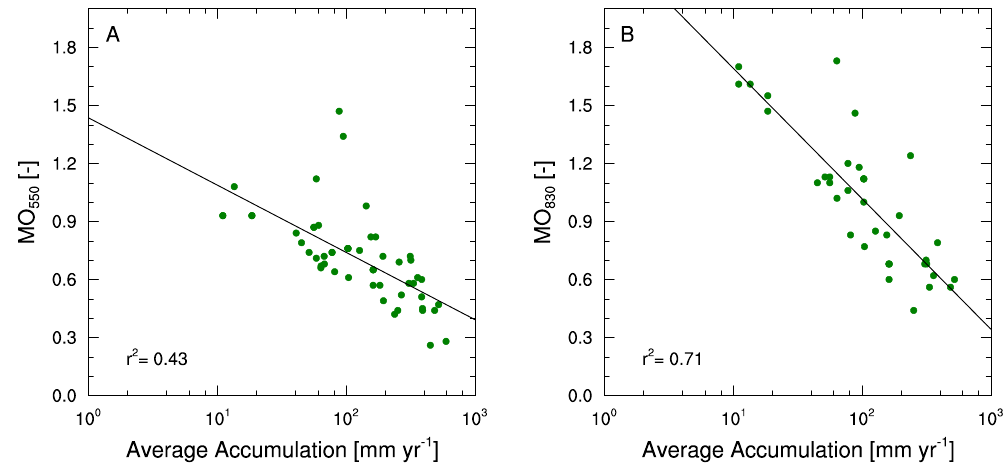
Fig. 5: MO-ratio of Ar10S for z 550 (A) and z ∗ listed in Eq. 8 and